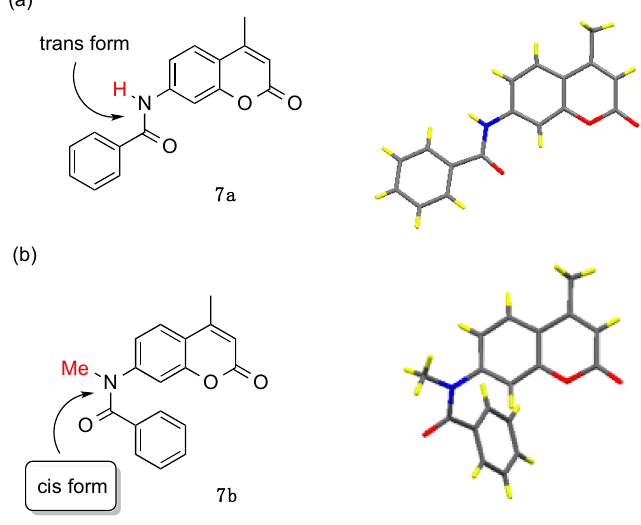
Figure 5. Crystal structures of compounds ( a ) 7a and ( b ) 7b .